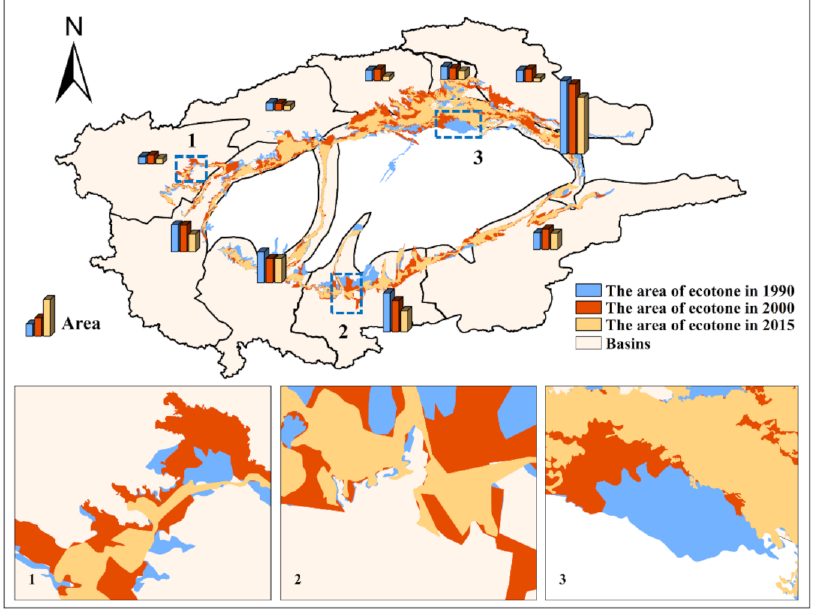
Figure 3. The areal extent of the ecotone in 1990, 2000, and 2015 in each basin. The lower maps show changes in the local ecotone in ( 1 ) the Weigan River Basin, ( 2 ) the Keriya River Basin, and ( 3 ) the main stream of the Tarim